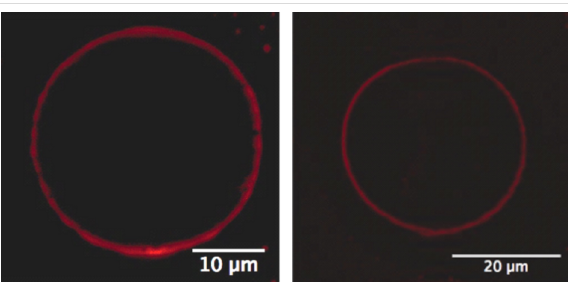
Figure 4: Confocal fluorescence microscopy of giant unilamellar vesi- cles (GUVs) of amphiphilic cyclodextrins with AdSq on their outer surface.